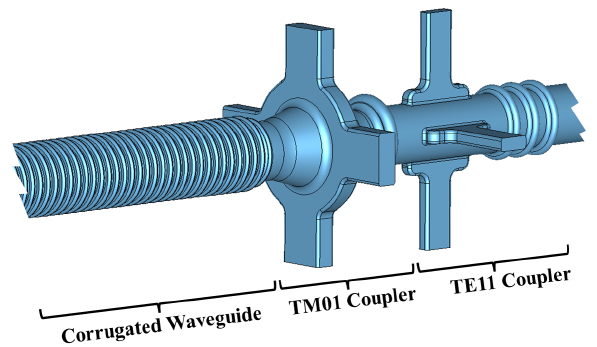
FIG. 1. Vacuum space of transition section couplers connected to a short section of the CWG accelerating